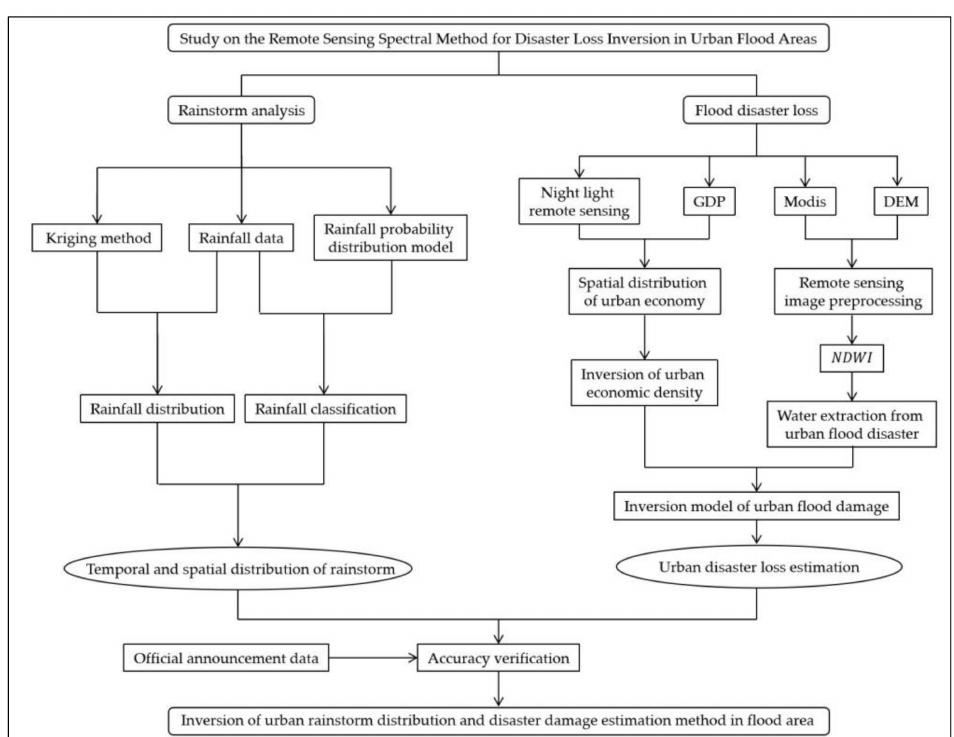
Figure 2. Flow chart of urban rainfall distribution inversion and flood remote sensing disaster loss calculation.